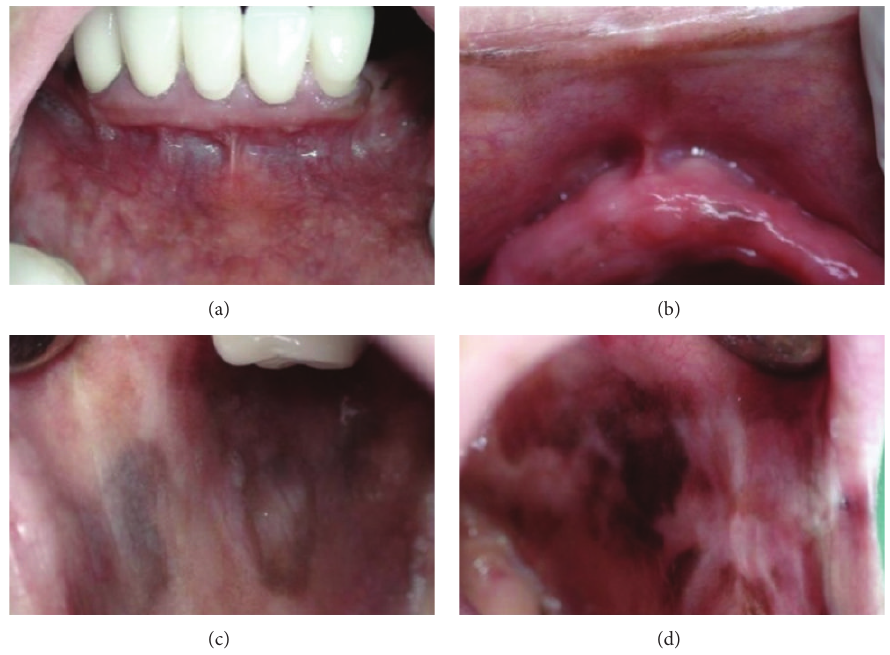
Figure 3: By the 12th month of follow-up, the pigmentation had